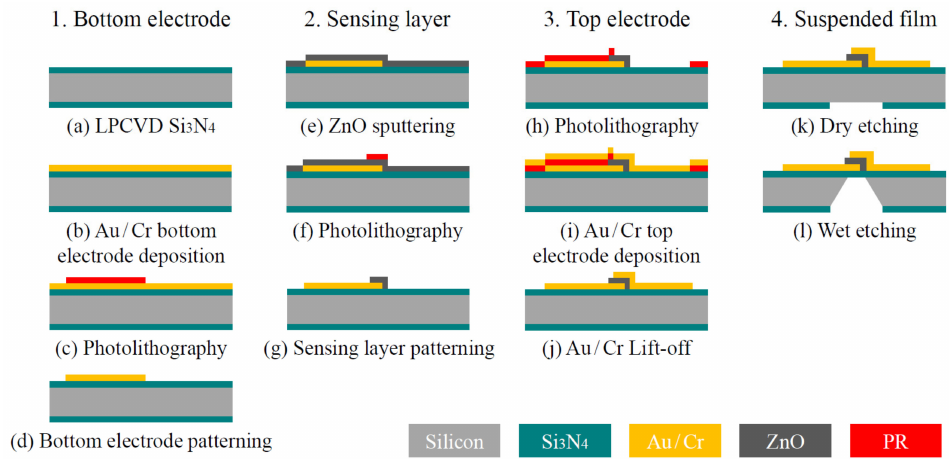
Figure 4. Schematic illustration showing main steps in fabrication process of pyroelectric infrared sensor: ( a ) LPCVD deposition of Si 3 N 4 , ( b ) E-beam deposition of Au/Cr bottom electrode, ( c ) pho- tolithography, ( d ) patterning of bottom electrode by wet etching, ( e ) RF sputter deposition of ZnO thin film, ( f ) photolithography, ( g ) patterning of sensing layer by wet etching, ( h ) photolithography, ( i ) E-beam deposition of Au/Cr top electrode, ( j ) lift-off, ( k ) dry etching of back Si 3 N 4 layer, and ( l ) KOH wet etching of silicon